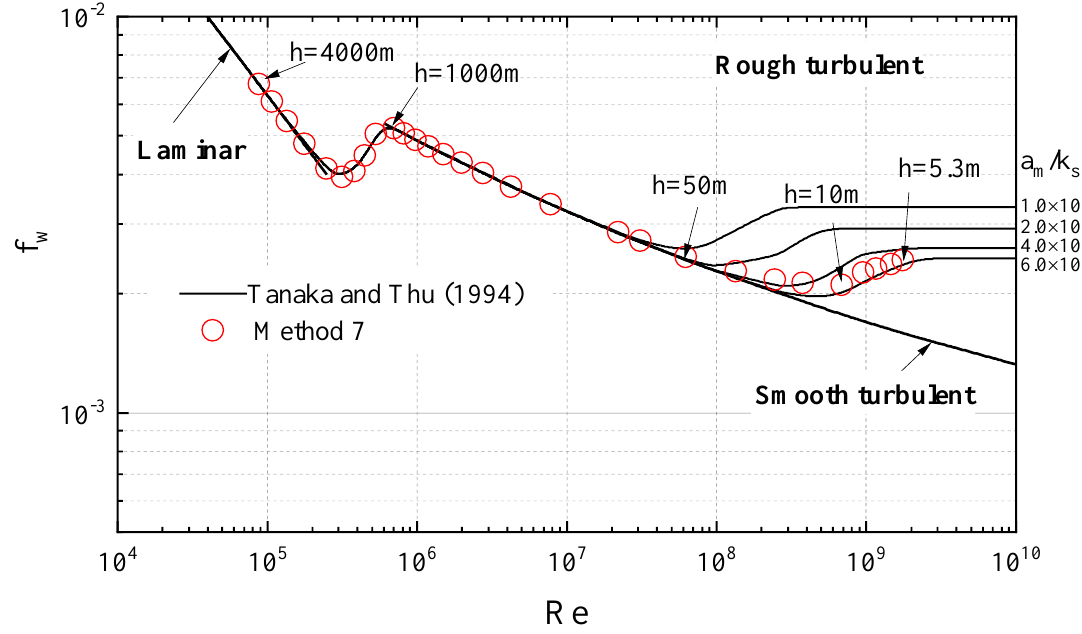
Figure 5. Variation of 𝑓 𝑤 under a shoaling tsunami (Method 7).